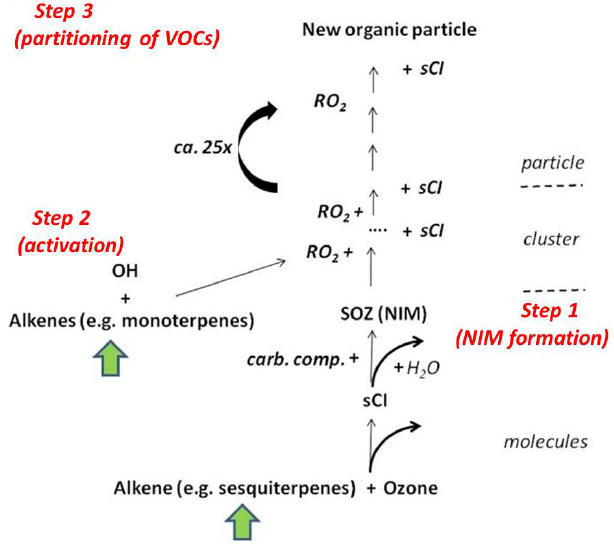
Figure 1. Particle formation scheme of hypothesis (C) by organic compounds only. Three essential steps, of which the first two can both limit nucleation, are